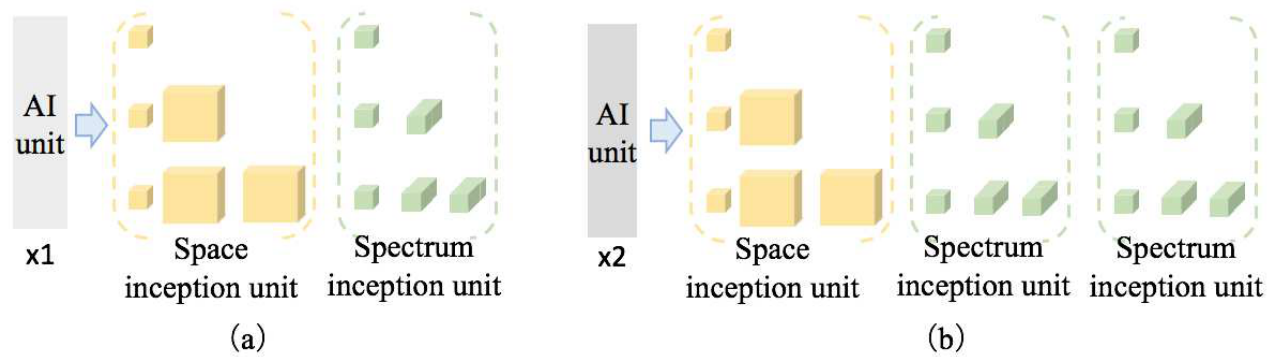
Figure 3. Illustration of stacking two AI units. ( a ) AI unit × 1; ( b ) AI unit × 2. Instead of stacking two AI units with the same type, we stack one space inception unit and two spectrum inception units to form AI unit × 2 as shown in ( b